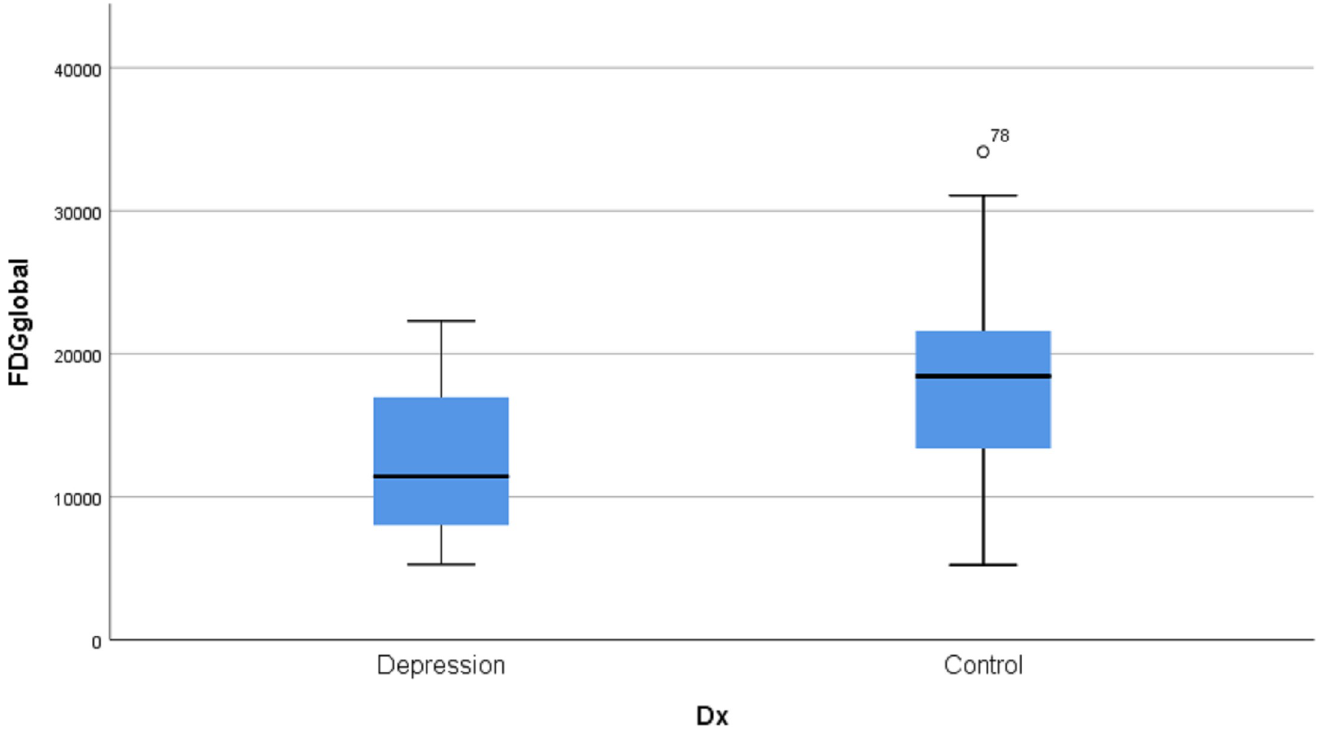
Fig 2. Box plot of global FDG activity in major depression group (D) and control group (N).